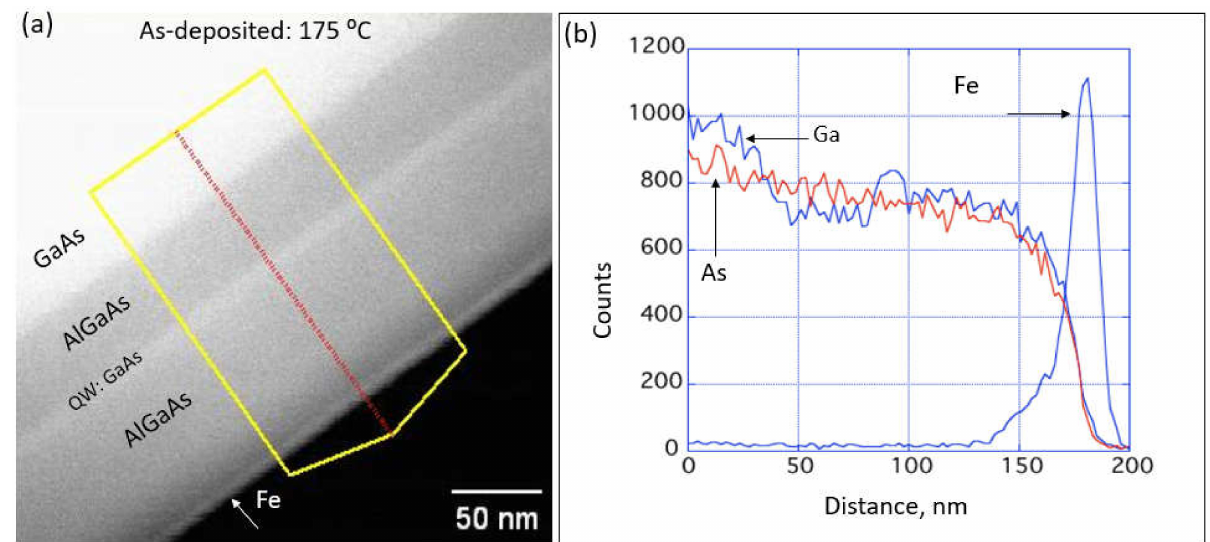
Figure 7. ( a ) An HAADF image of the Fe film deposited at 175 ◦ C on AlGaAs/GaAs/AlGaAs/ GaAs(subs) template. ( b ) The corresponding compositional line-scan showing intermixing of Fe in AlGaAs at the interface.